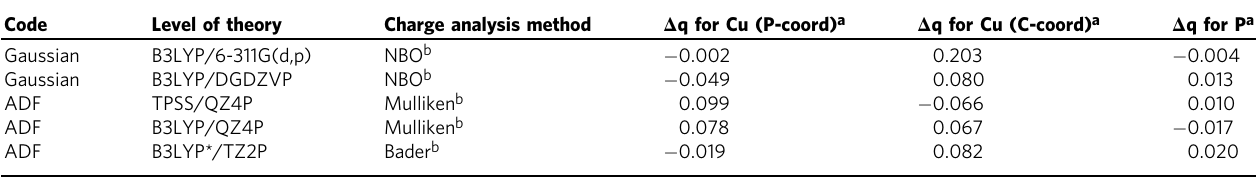
Table. 1 Differences between average atomic charges for excited triplet state and ground state. .